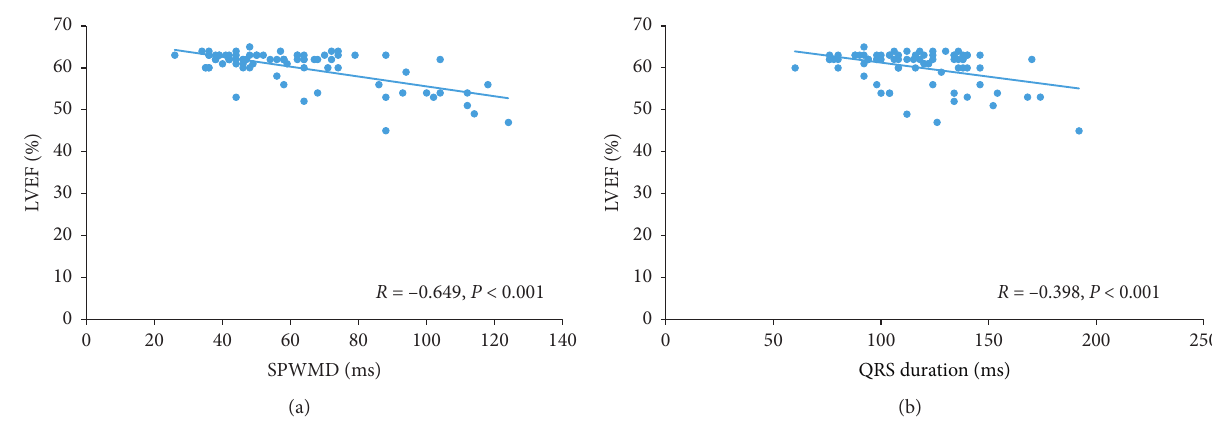
Figure 2: Correlation between LVEF and septal-to-posterior wall motion delay (SPWMD) or QRS duration in all patients ( n � 80). There were negative correlations between initial LVEF and initial SPWMD (a) or initial QRS duration (b). Moreover, SPWMD had a higher correlation with LVEF than initial QRS